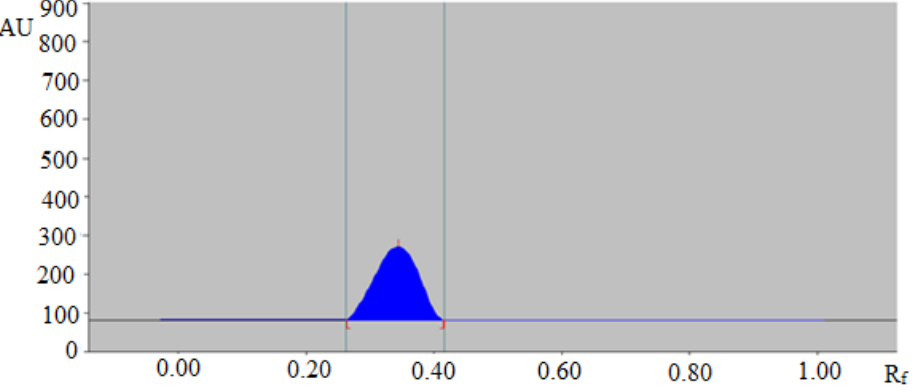
Figure 1. High-performance thin layer chromatography (HPTLC) densitogram of standard trans-anethole (TAL).